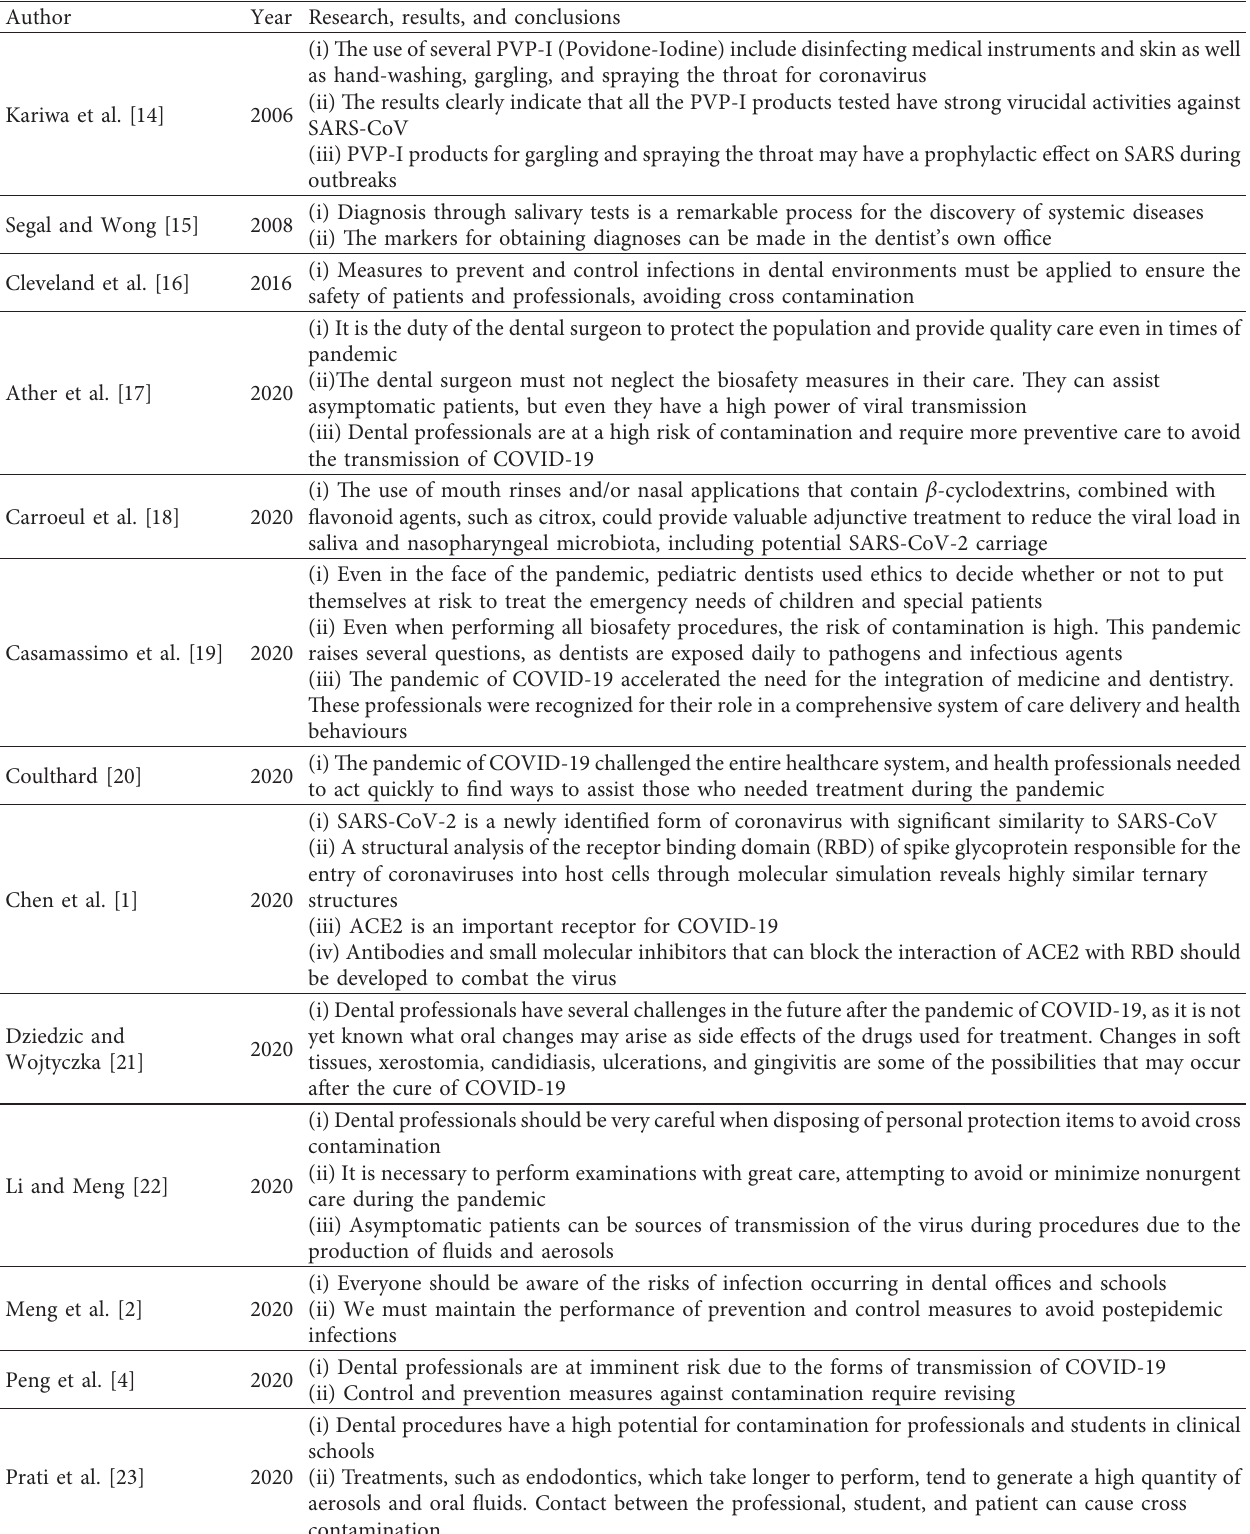
Table 1: The potential of SARS-CoV-2 transmission in a dental clinic and measures to prevent and control the infection in dental